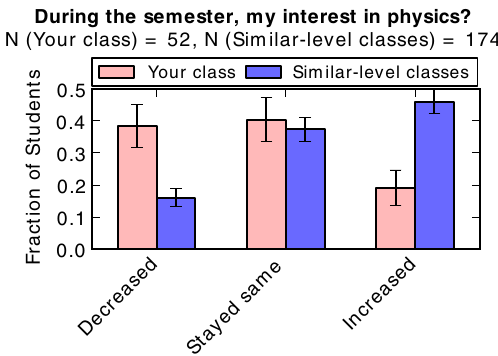
FIG. 8. Change in students ’ interest in physics. Your class (red) refers to your own class. Similar-level classes (blue) refers to a set of students in all classes at the calculus-based introductory